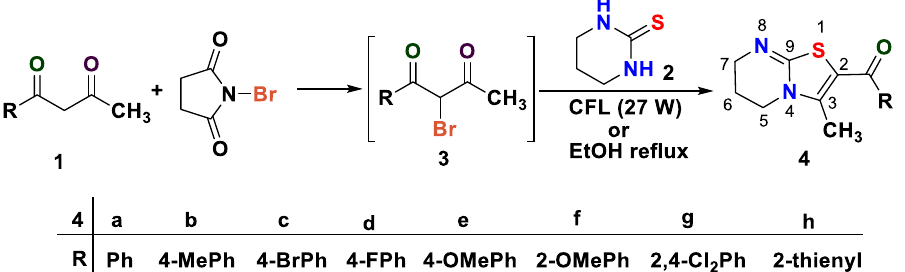
Figure 2. One-pot regioselective synthesis of 2-aroyl/heteroaroyl-3-methyl-6,7-dihydro-5 H -thiazolo[3,2- a ] pyrimidine